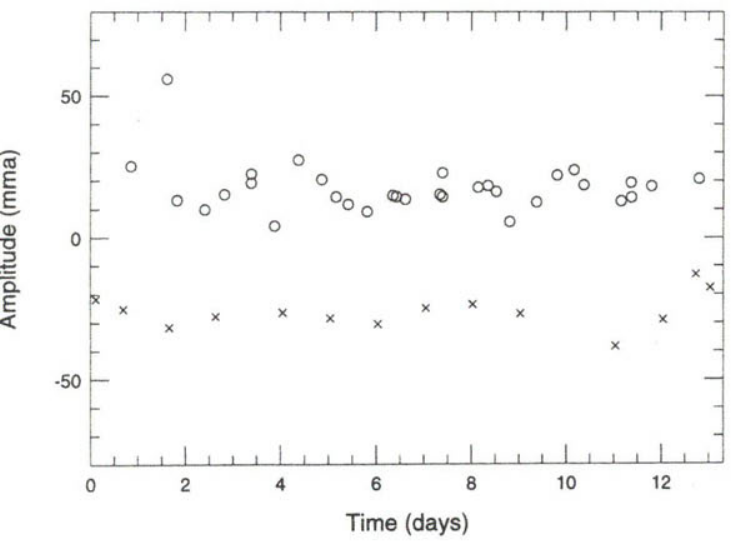
Fig. 4. Amplitudes of a pulsation mode measured in a WET run by standard WET photometers ( X - displaced by 40mma) and all others in the network